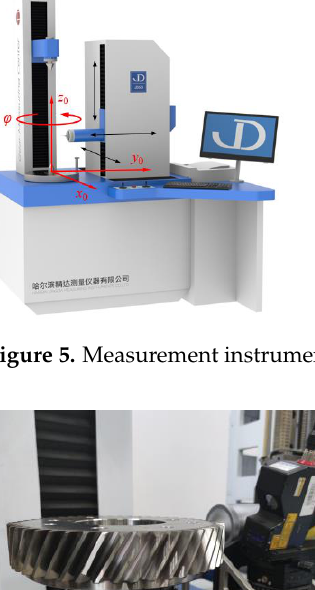
Figure 6. Gear measurement process.